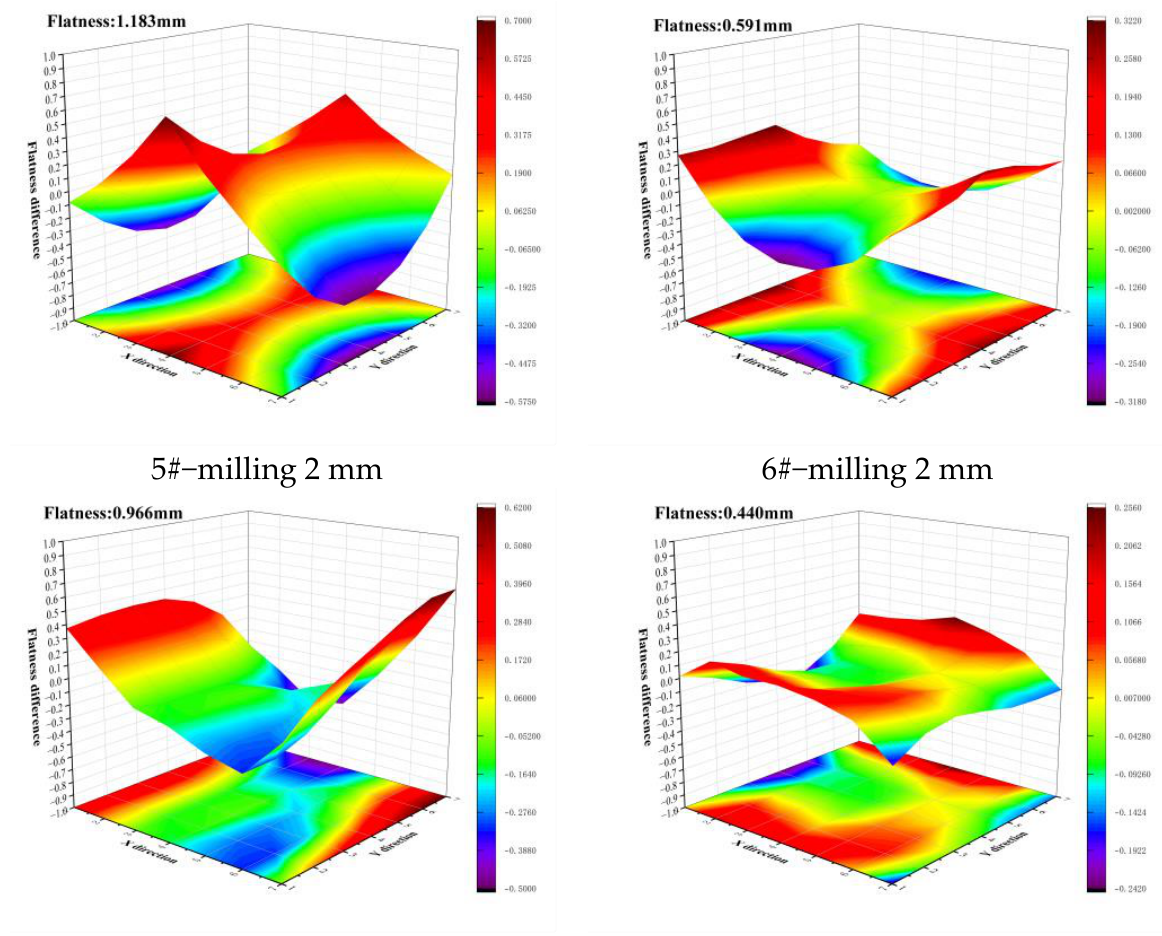
Figure 10. 7075 Alloy plate deformation cloud after unilateral milling 2 mm and 3 mm.